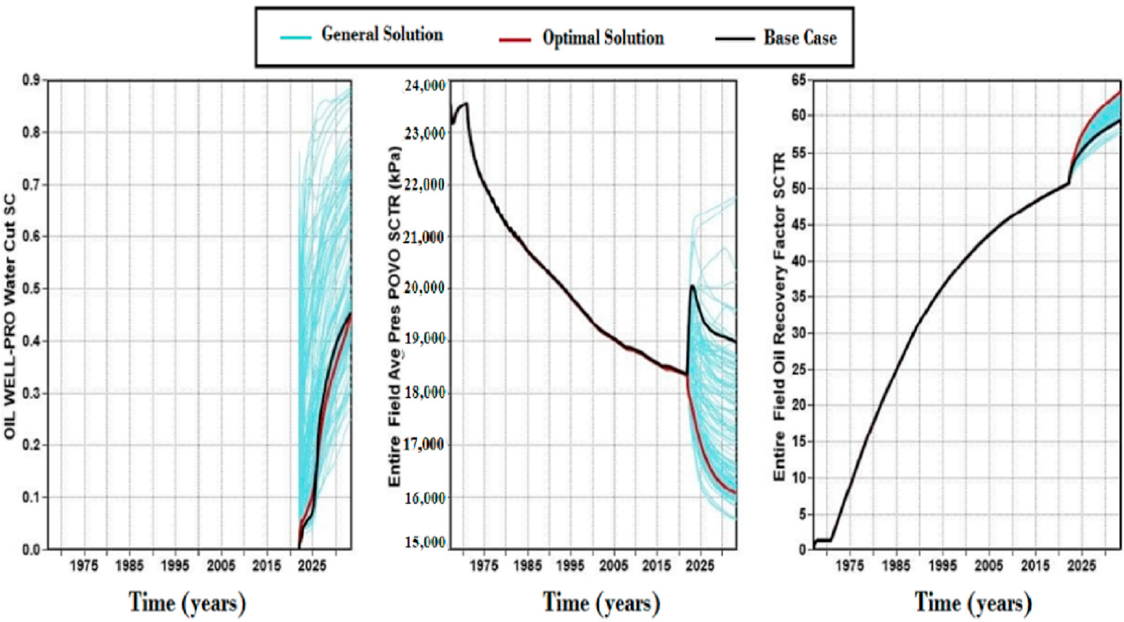
Figure 13. PSO-derived optimum water cut solution resulting from the evaluation of five hundred simulation cases. Left: oil well water cut; middle: average reservoir pressure; and right: oil recovery factor.